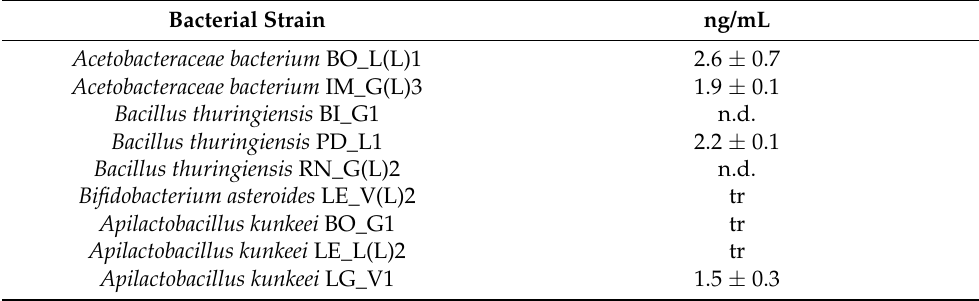
Figure 2. Comparison of the mass spectra of 2-heptanone from the SPME extract of the Acetobacteraceae bacterium strain IM_G(L)3 culture filtrate ( a ) and from the synthetic standard ( b ) to the spectrum stored in the Wiley 7n library ( c ). m/z = mass/charge. Table 1. Concentration of 2-heptanone in the bacterial culture filtrates (average of 2 replicates ± standard deviation). Tr = traces and n.d. = not detected.